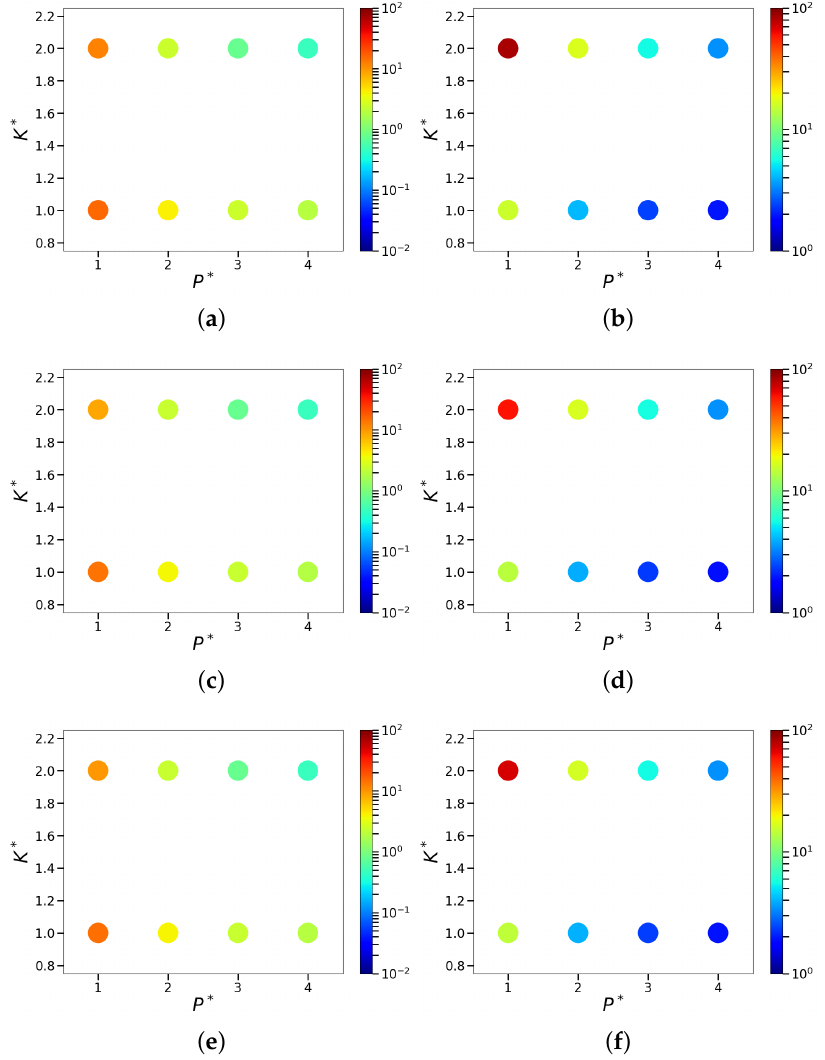
Figure A8. Isocontours of the normalized mean squared ( l 2 ) ELM-based sparse reconstruction errors of Re = 800 case for maximum, minimum, and average error using different choices for the random input weights in learning the basis. Left: normalized absolute error metric, (cid:101) 1 . Right: normalized relative error metric, (cid:101) 2 . ( a ) (cid:101) 1 (maximum); ( b ) (cid:101) 2 (maximum); ( c ) (cid:101) 1 (minimum); ( d ) (cid:101) 2 (minimum); ( e ) (cid:101) 1 (average); and ( f ) (cid:101) 2